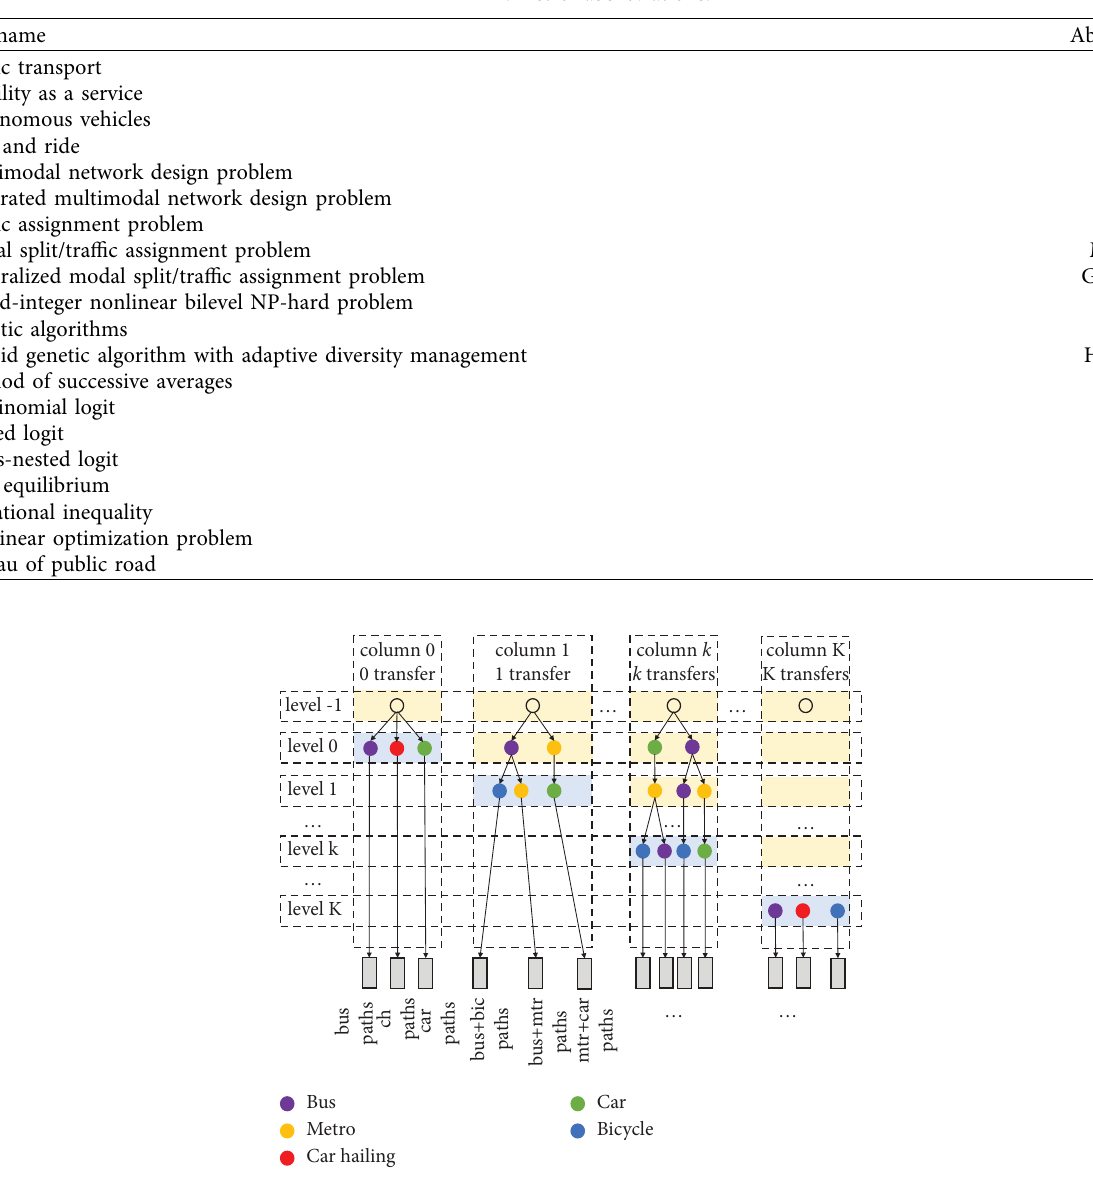
Figure 1: Mode-choice structure based on the nested logit